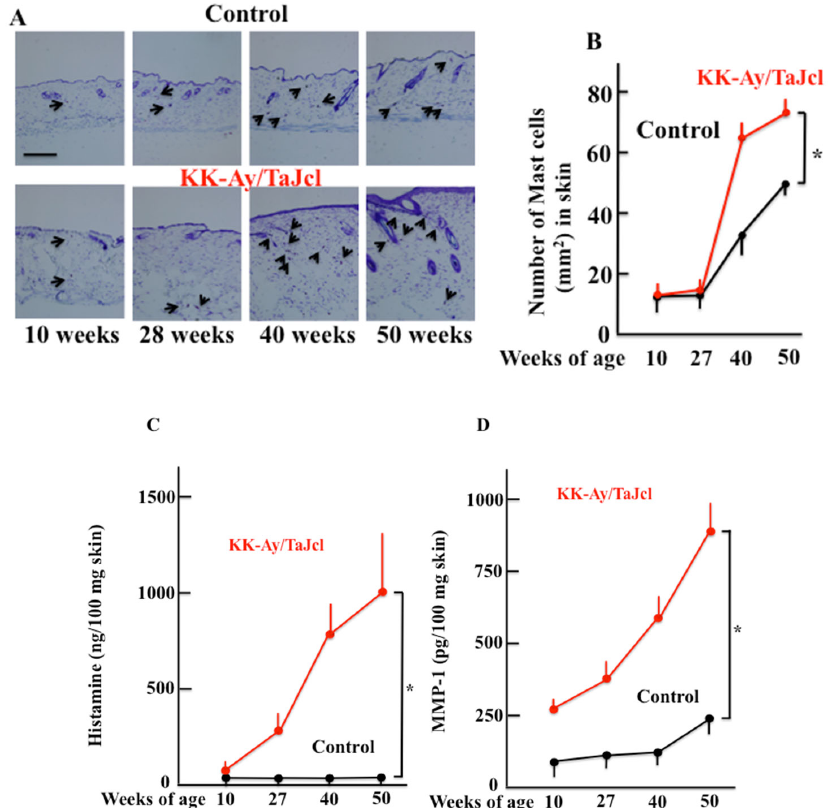
Figure 3. Effect of aging in KK-Ay/TaJcl mice on the expression of mast cells ( A , B ), and levels of histamine ( C ) and MMP-1 ( D ) in the dorsal skin. Arrows indicate mast cells stained with toluidine blue. The data show one representative experiment containing five animals. Scale bar = 100 μ m. The dorsal skin levels of histamine and MMP ‐ 1 in mice were measured using ELISA. Values are expressed as mean ± SD derived from five animals. * p < 0.05. Control: C57BL/6j mice.